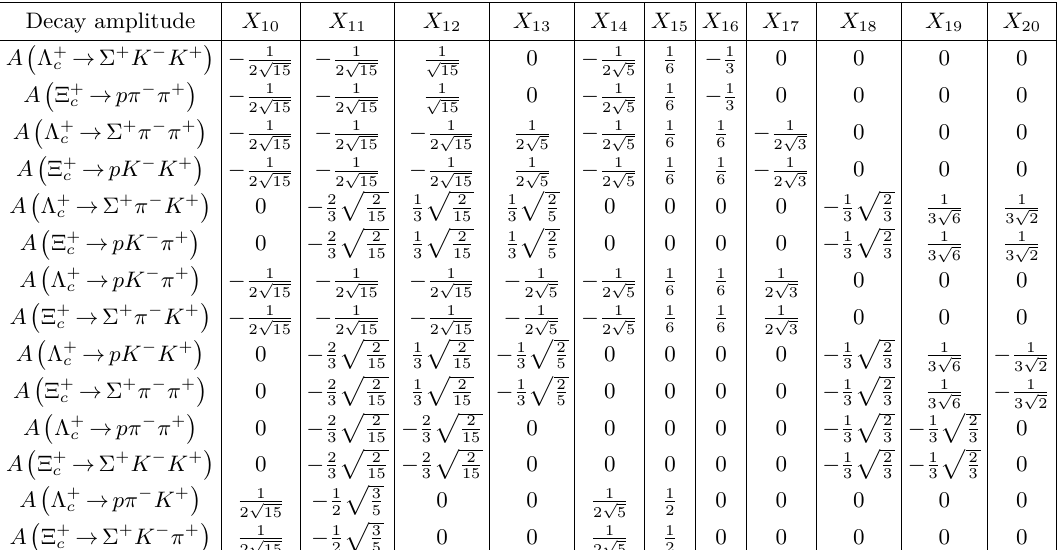
are defined in eq. α